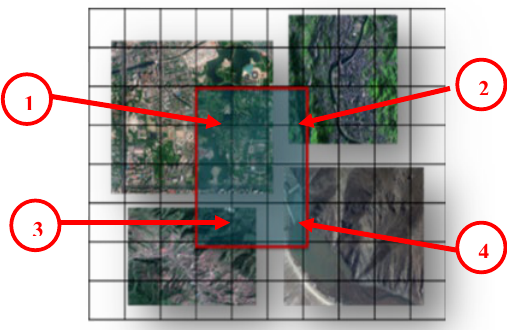
Figure 5. Search and display the remote sensing big data